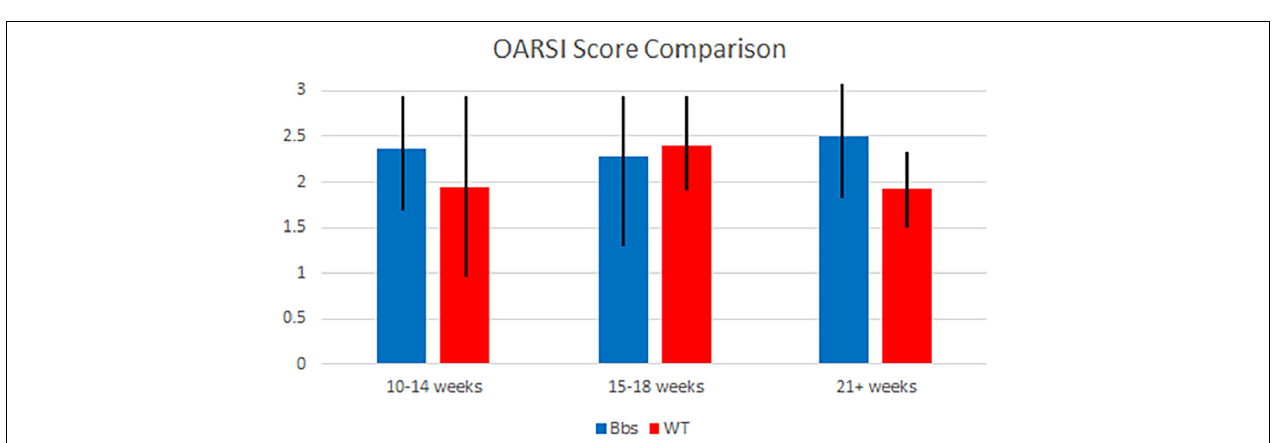
FIGURE 2 | Histological comparison of WT and Bbs1 M390R/M390R mutant knee joints. (A) Knee joint stained with Safranin-O Fast Green from a 17-week-old male WT mouse. (B) Knee joint stained with Safranin-O, Fast Green from an 18-week-old male Bbs1 M390R/M390R mutant mouse. Note the surface erosion and exaggerated thickness of cartilage. Bbs1 M390R/M390R mutant knees exhibited significantly thicker cartilage compared to WT controls ( p < 0.01). However, Bbs1 M390R/M390R mutant mice do not exhibit higher than normal OARSI or Mankin scores.